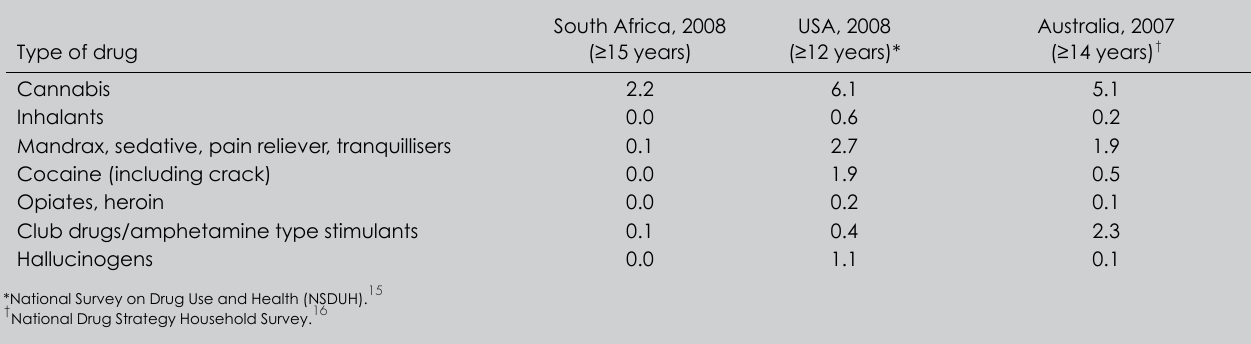
Table IV. Comparisons of current (past month) illicit drug use epidemiology: South Africa, USA and Australia